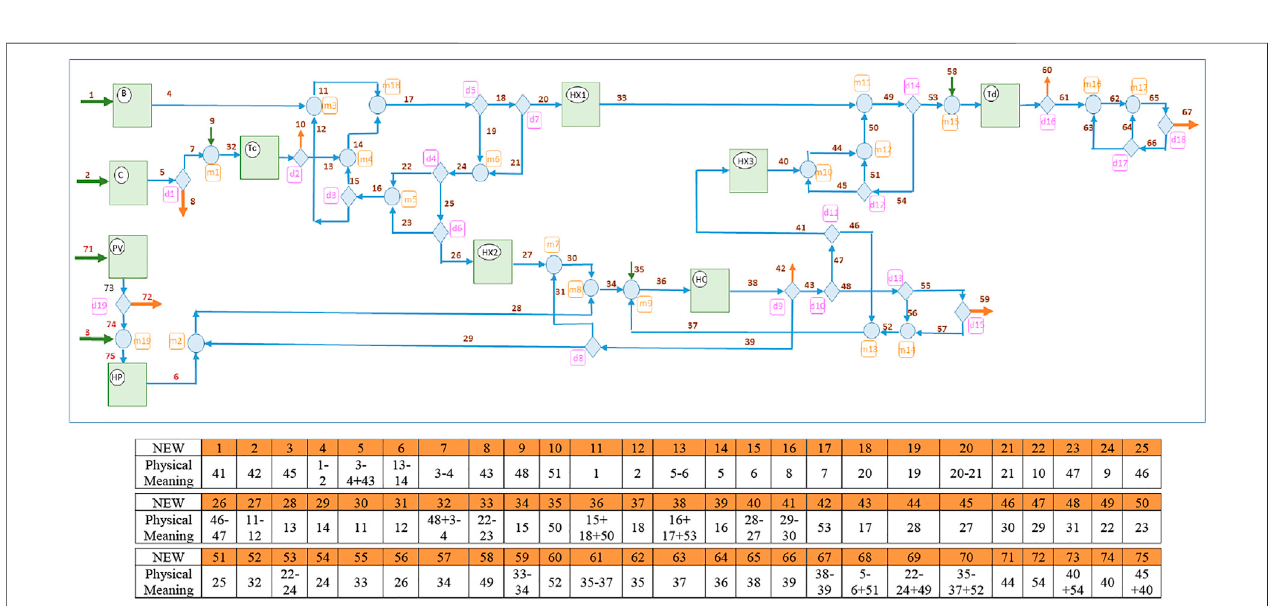
FIGURE 7 | : New Numbering and de fi nitions of fl ows in the Productive super-structure to facilitate the application of proposition.